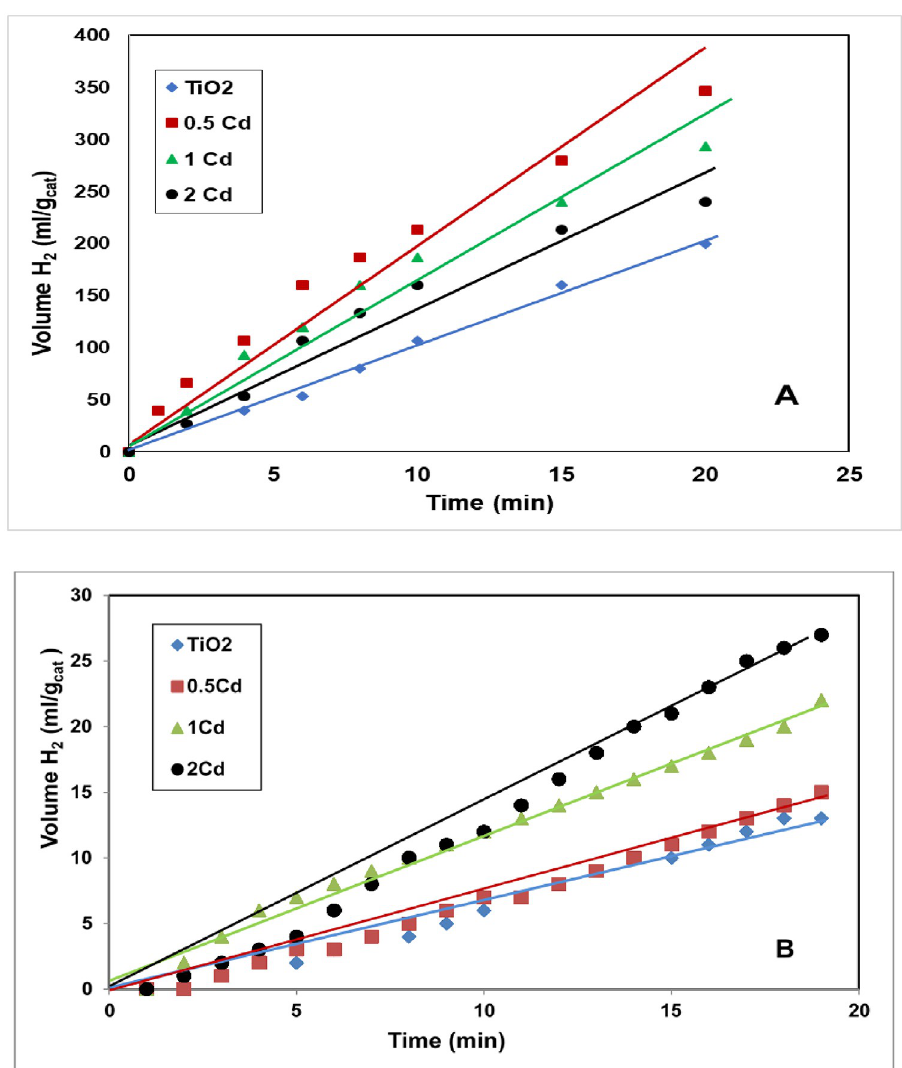
Fig 5. Effect of Cd content on H 2 evolution rate in case of utilizing Cd-doped nanofibers; (A) and nanoparticles; (B) as